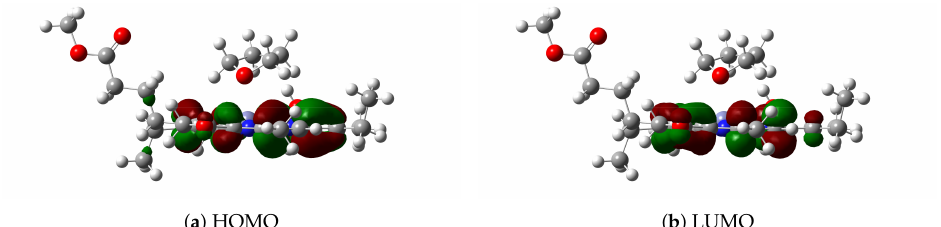
Figure 4. ( a ) HOMO and ( b ) LUMO of model 3.